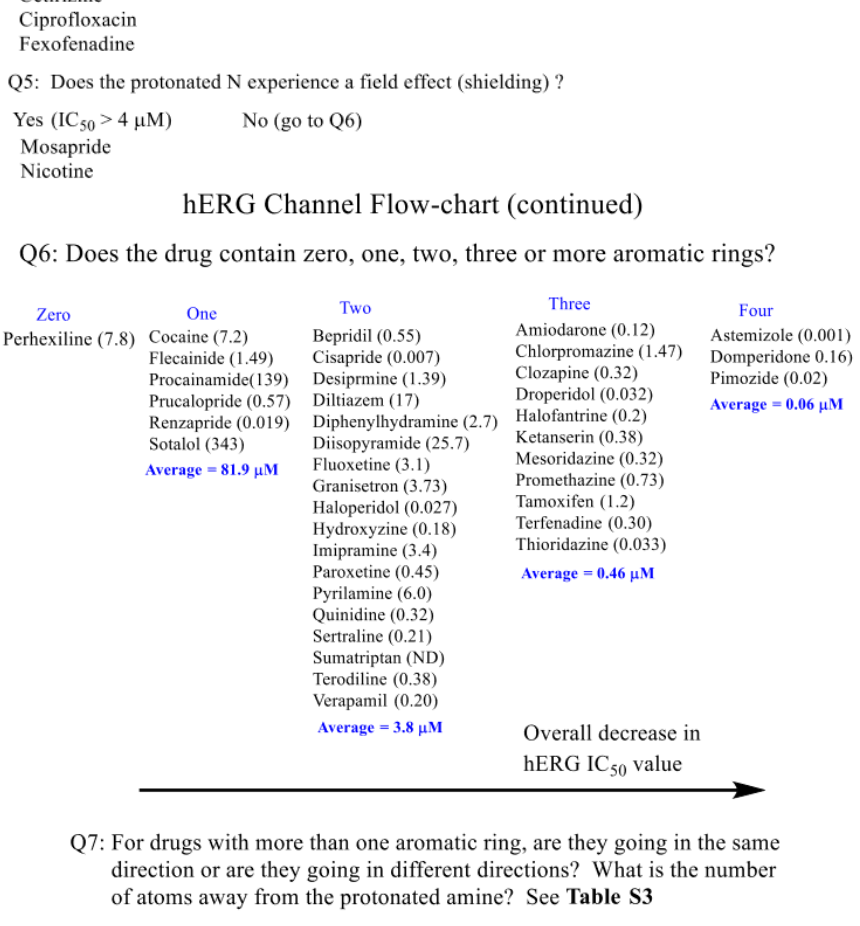
Scheme 1. hERG channel prediction flow chart for first compound